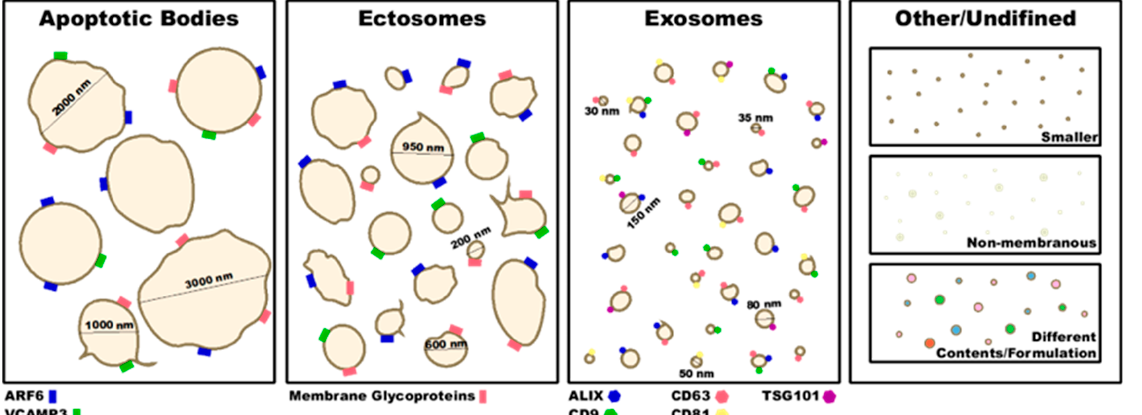
Figure 1. Subtypes of Extracellular Vesicles. There are three main subtypes of extracellular vesicles (EVs) that have been characterized to date, apoptotic bodies, ectosomes (microparticles/microvesicles), and exosomes. Apoptotic bodies are large (greater than 1000 nm in diameter) and heterogenous in size and shape due to them originating from plasma membrane blebs. Ectosomes, are also heterogenous in size and shape and can range from 150–1000 nm in diameter. Exosomes are more homogenous in size and shape, being 30–150 nm in diameter and mostly round, as they are produced via a regulated process., Apoptotic bodies and ectosomes originate from the plasma membrane and can express specific markers ARF6, VCAMP3, and membrane glycoproteins. Exosomes can be identified by the markers ALIX, CD9, CD63, CD81, and TSG101. While these three EV types have been characterized, emerging technologies are revealing new EV populations that have yet to be characterized. These include EV populations that are smaller, are non-membranous, and/or have different contents and mechanisms of